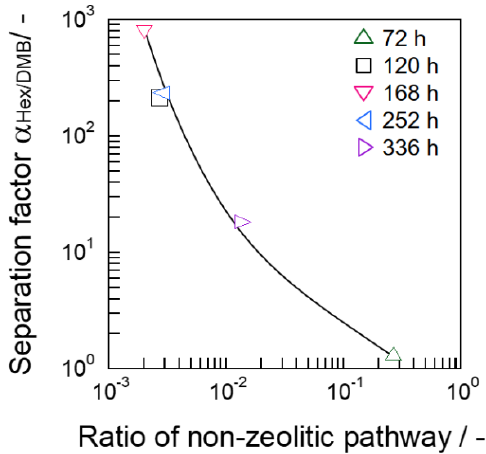
Figure 9. Relationships between the ratio of non-zeolitic pathway and selectivity of hydrocarbon. Membranes were crystallized for (cid:52) , 72; (cid:3) , 120; (cid:53) , 168; (cid:47) , 252; (cid:46) , 336 h.